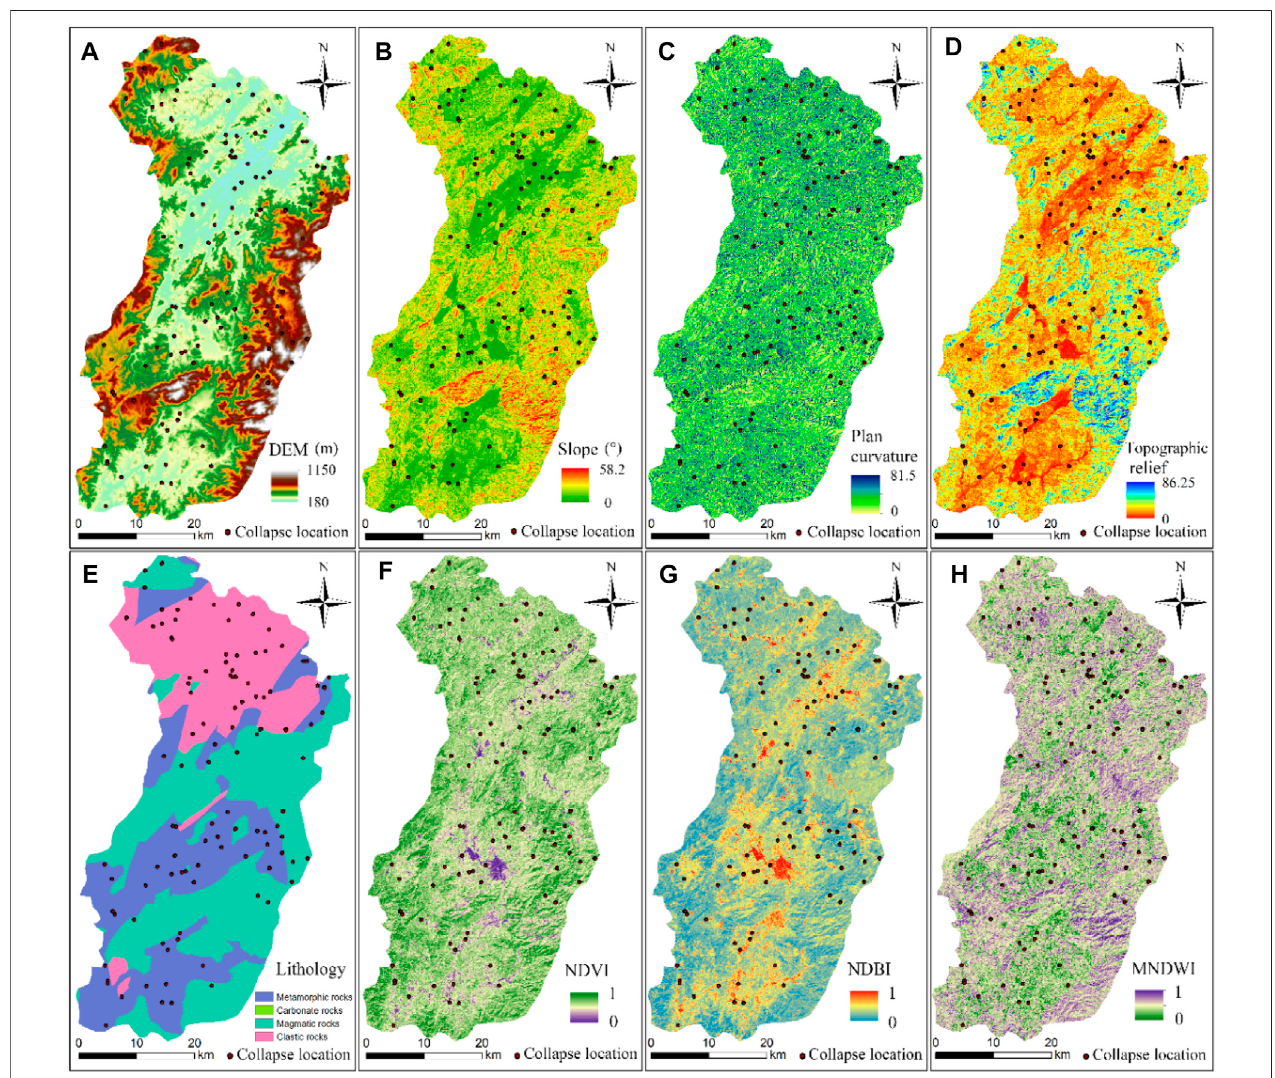
FIGURE 4 | Environmental factors (A) elevation; (B) slope; (C) Plan curvature; (D) Topographic relief; (E) lithology; (F) NDVI; (G) NDBI; (H) MNDWI (Aspect, Pro fi le curvature and distance to rivers are not present).